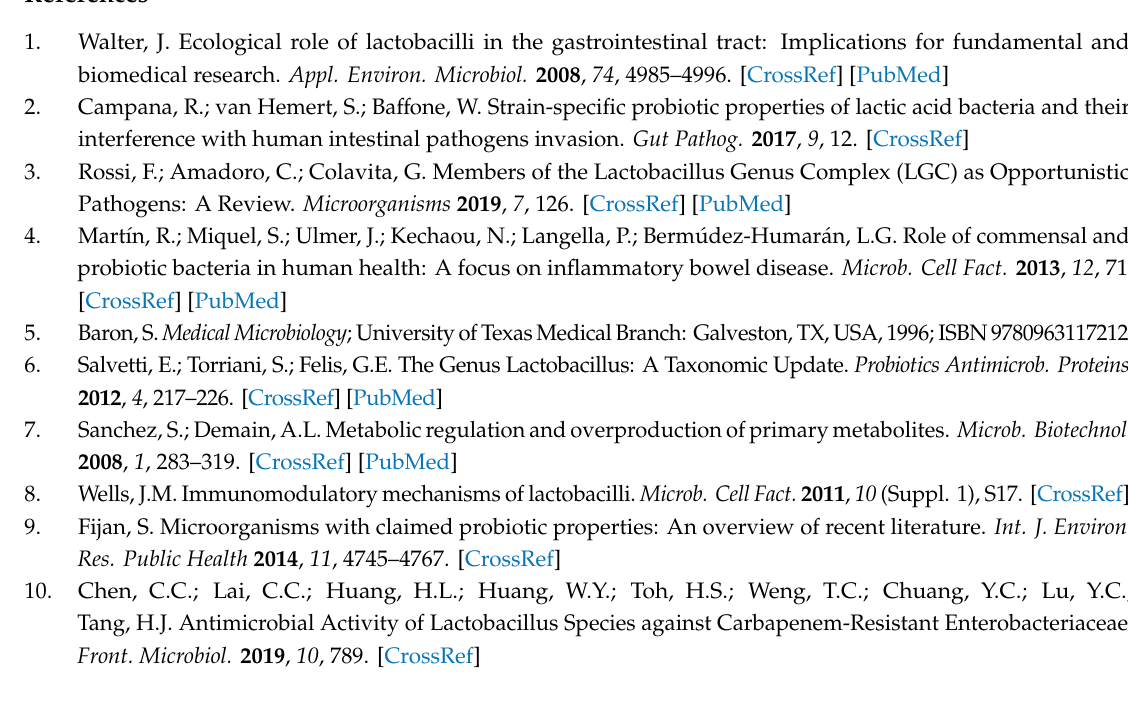
Table S1: Supplementary information about the ten Lactobacillus